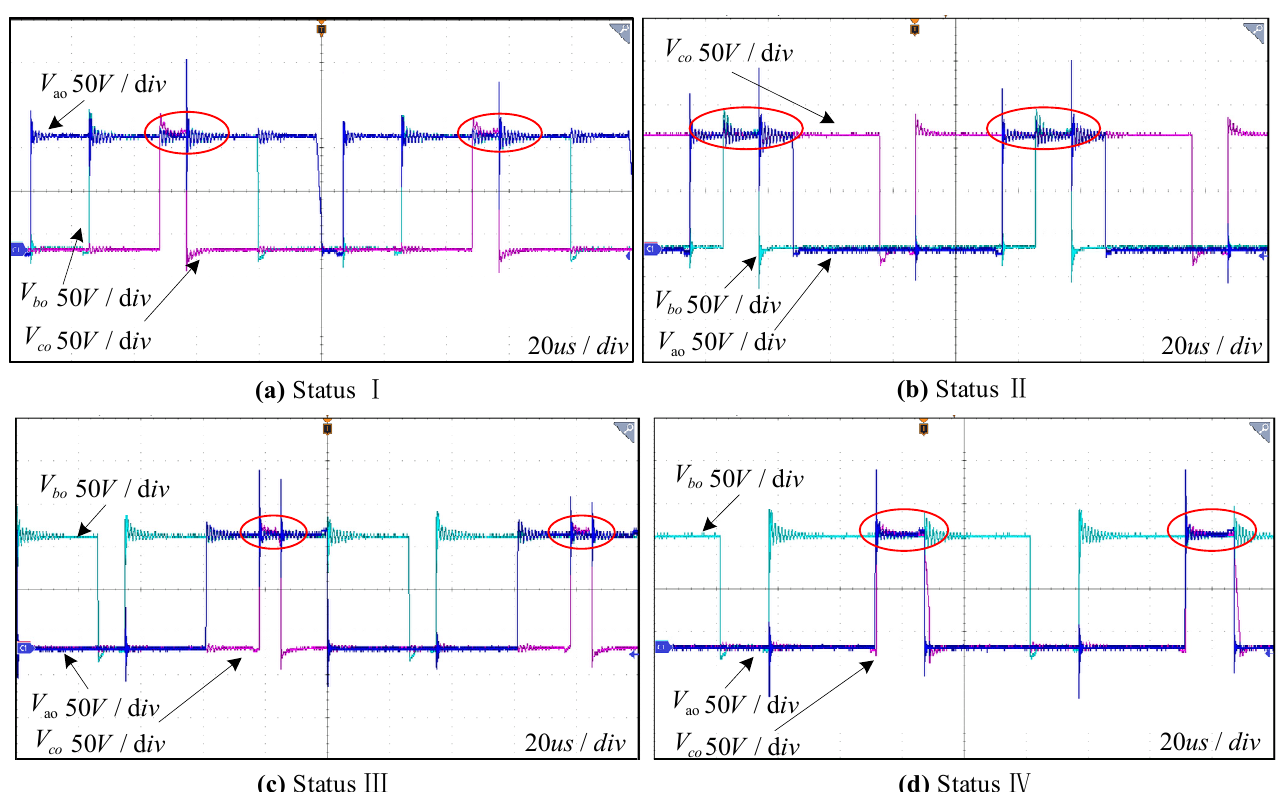
World Electr. Veh. J. 2021 , 12 , x Figure 9. Three ‐ phase voltage waveform of SVPWM different switching states . Figure 9. Three-phase voltage waveform of SVPWM different switching states.